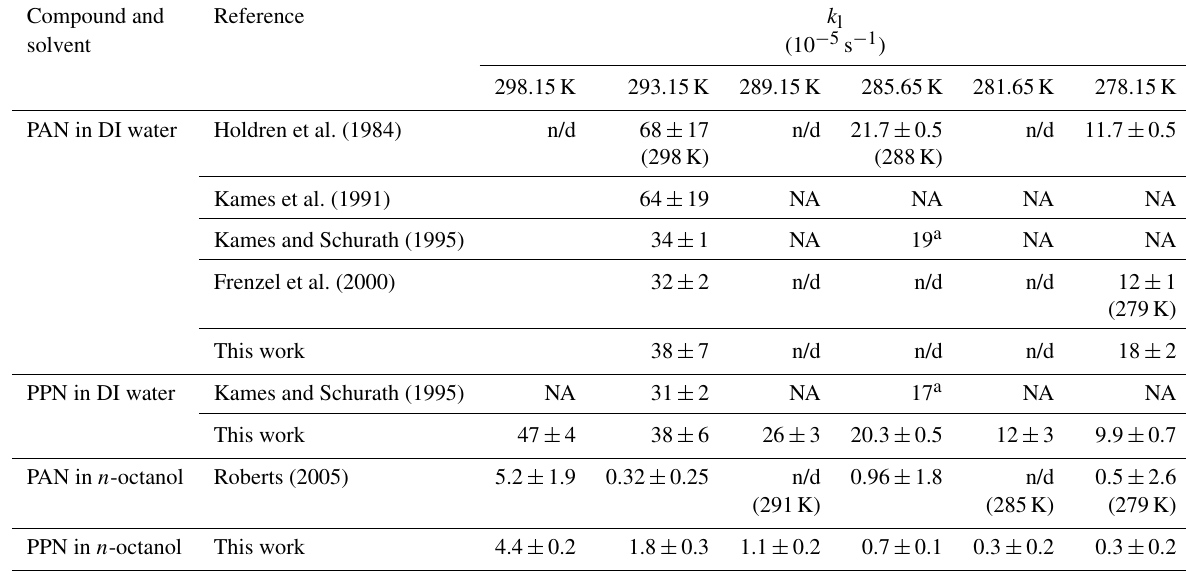
Table 4. Summary of liquid-phase loss rate constants. Compound and